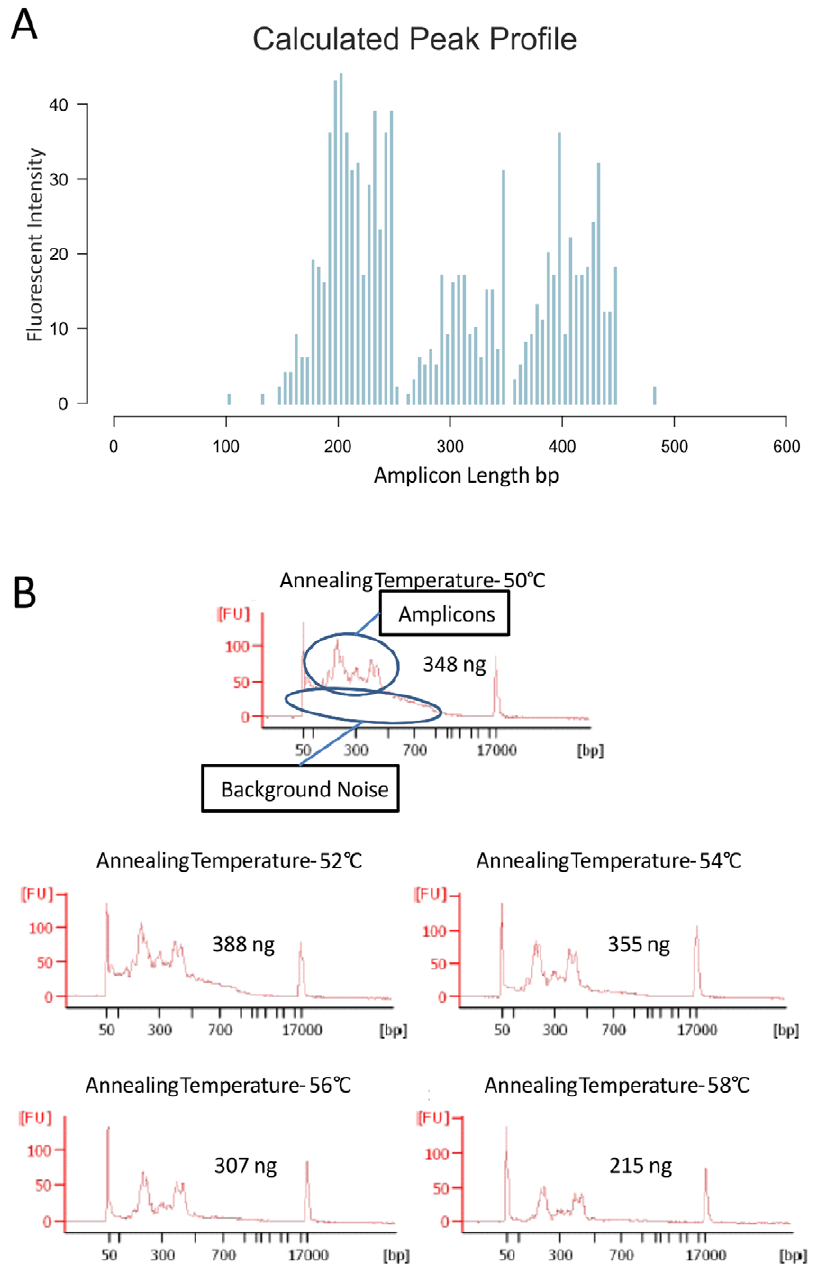
Figure 1. Annealing temperature optimization of the primer droplet library. Panel A – The calculated peak profile created by generating a histogram of the known amplicon sizes and numbers and assuming equal representation of all the amplicons after PCR amplification. Panel B – The Agilent Bioanalyzer traces of merged samples PCR amplified with different annealing temperatures. The amplicon peaks and background noise are highlighted for the 50 u C annealing temperature. Background noise decreases until it disappears at 56 u C. Increasing the annealing temperature to 58 u C only results in a decrease in amplicon yield.